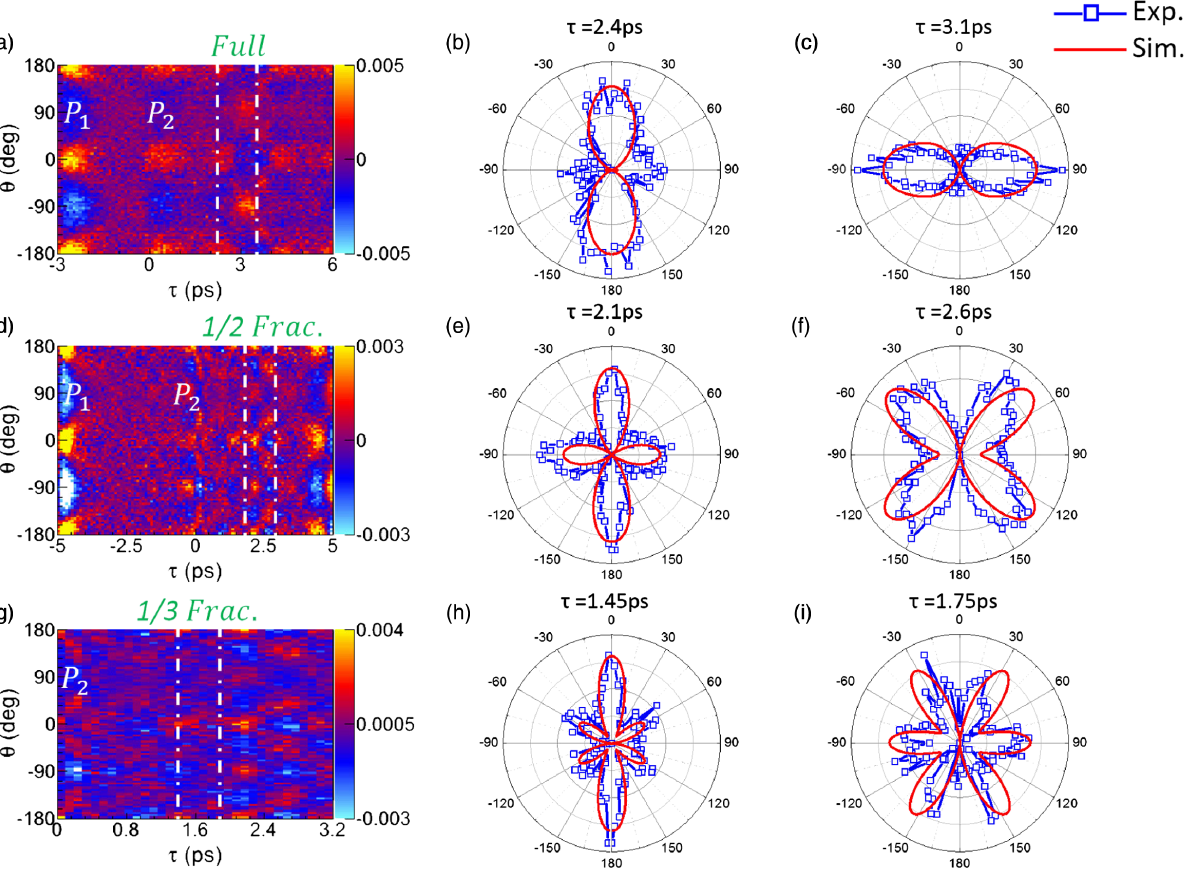
FIG. 5. Time-dependent angular distributions of full, 1 = 2 and 1 = 3 echoes, as indicated between the white dashed lines in (a) 2.2 ps — 3.5 ps, (d) 1.9 ps — 3.0 ps, and (g) 1.4 ps — 1.9 ps, experimentally measured and theoretically simulated for CO 2 . (a) Carpet of the angular distribution of full echo for parallel input pulses, P 1 and P 2 , with T ¼ 3 ps time delay between them. (b) and (c) Polar plots of the alignment and anti-alignment regions of the distribution for the full echo, showing vertical and horizontal directionality, respectively. (d)-(f) The same, for the 1 = 2 fractional echo, with T ¼ 5 ps time delay. (g)-(i) The same for 1 = 3 fractional echoes with T ¼ 5 ps time delay. In all cases, the solid red line is the quantum-mechanically simulated